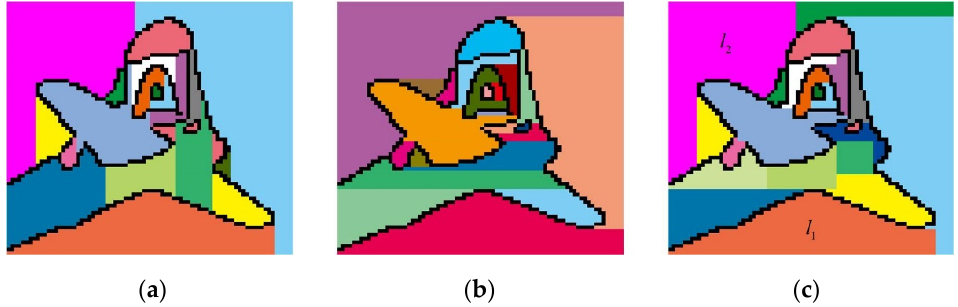
Figure 6. The jointly homogeneous map combined by orthogonal initial homogeneous maps. ( a ) the φ after merging adjacent initial regions in Figure 4c; (b) the com- compact initial vertical scan map ' compact initial vertical scan map φ (cid:48) v after merging adjacent initial regions in Figure 4c; ( b ) the v φ ; ( c ) the jointly homogeneous map ψ . compact initial horizontal scan map φ (cid:48) h ; ( c ) the jointly homogeneous map ψ pact initial horizontal scan map ' h